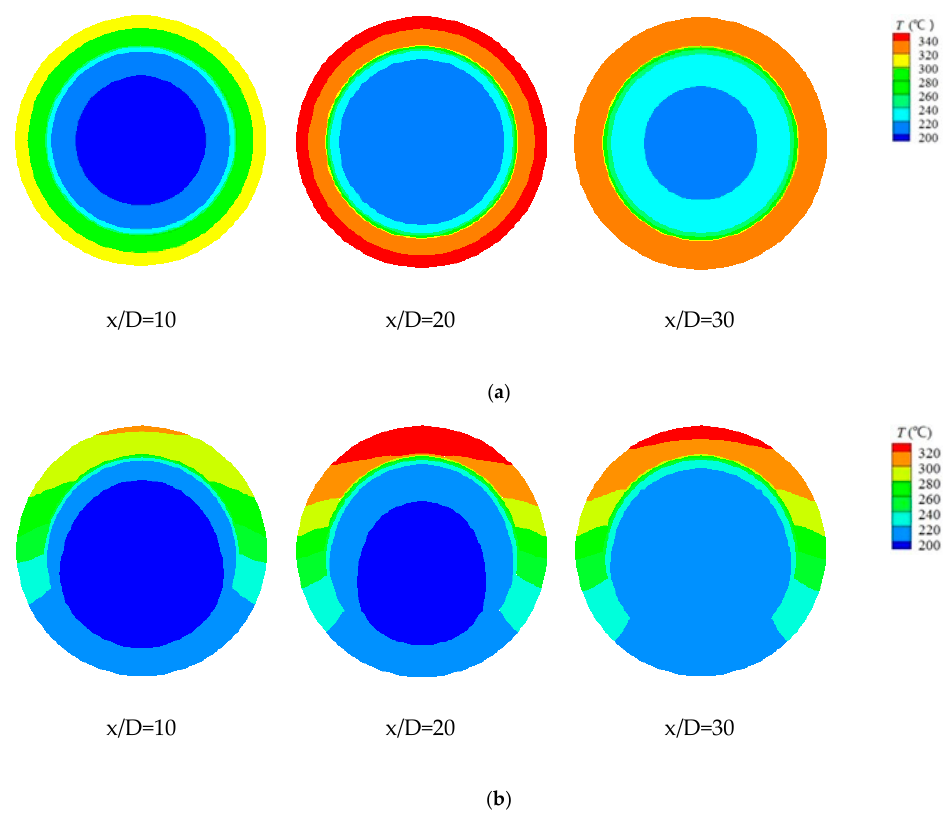
Figure 7. Temperature filed at different location: ( a ) uniform heating, ( b ) semicircular heating.